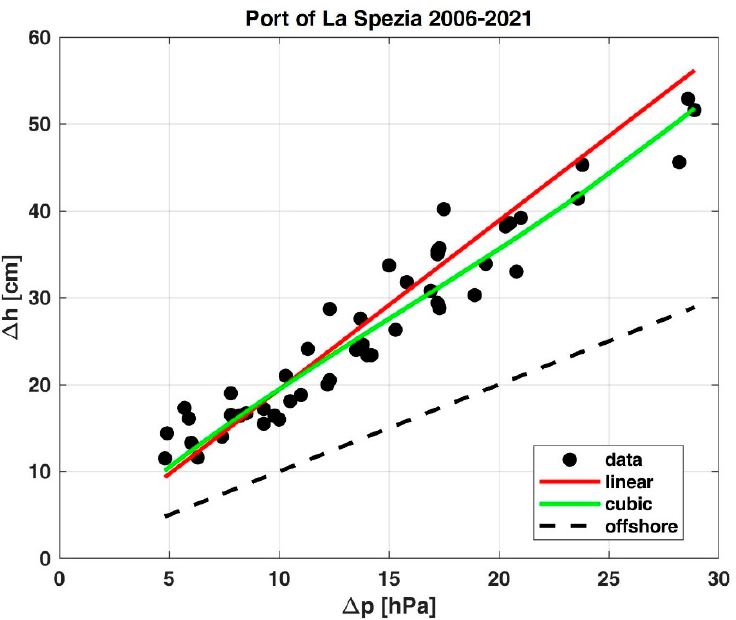
Figure 7. Measured pairs ( ∆ p , ∆ h ) from 2006 to 2021 in the port of La Spezia (black dots), linear (red) and cubic (green) trends and comparison with the offshore case (black dashed